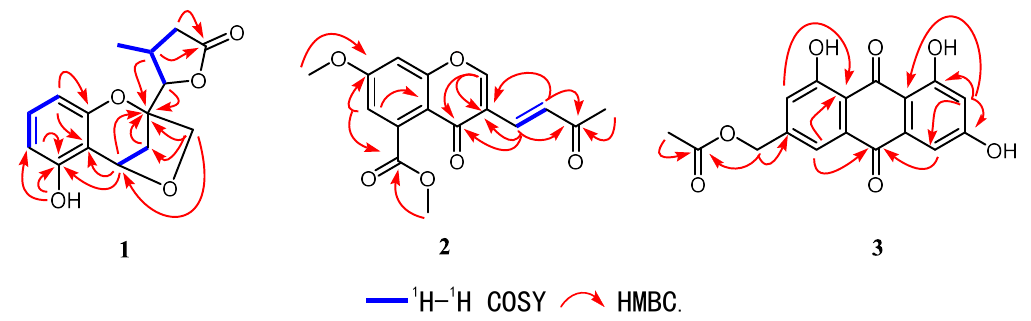
Figure 2. Key 1 H– 1 H COSY and HMBC correlations for compounds 1 – 3 .